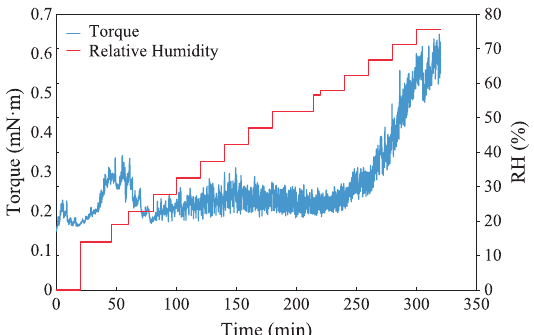
Fig. 2 Torque curve of the coffee creamer sample at 23 °C obtained with the Anton Paar Rheometer, with an in- crease of the relative humidity at the set temperature and the torque change of the material due to this rela- tive humidity